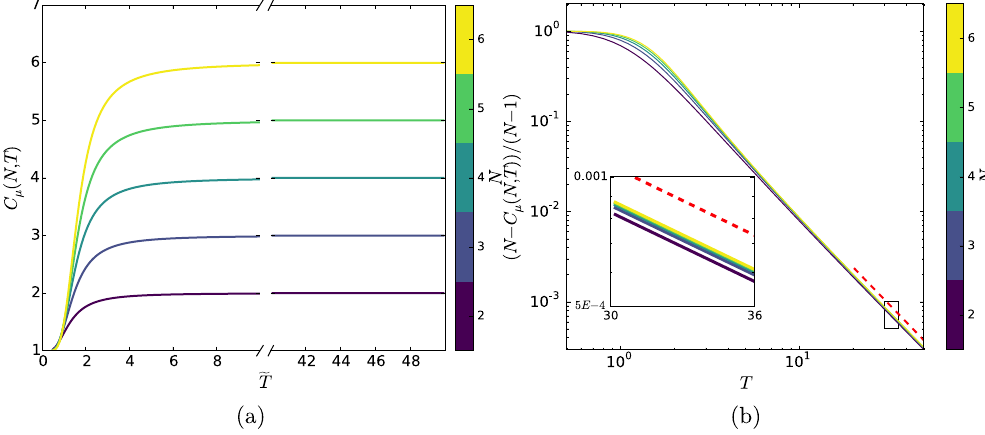
Figure 3. ( a ) Classical memory C μ ( N , T ) required for simulating process N T ( , )  for interaction ranges = … N 1, , 6 , a range of temperatures = … T 1, , 50 , and δ = 2. Note C μ (·) is an increasing function of N and T . ( b ) Rescaling the classical memory requirement C μ ( N , T ) to ( N − C μ )/( N − 1) shows a tight data collapse, which is especially strong at high temperatures ( T > 2). The asymptotic behavior is a power law with scaling exponent γ = 2. The inset zooms in to show C δ = 2, the μ ’s convergence with increasing N . While the figure shows the case slope γ at high T is independent of δ